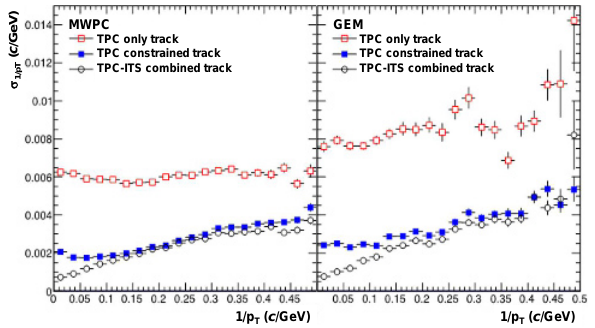
Figure 5. Momentum resolution of the current TPC (left) and the expected resolution of the upgraded TPC (right) as a function of 1 / p T . Open squares are for TPC information only, closed squares show track fits including the primary vertex, and open circles show the result for combined fits to TPC and ITS tracks.